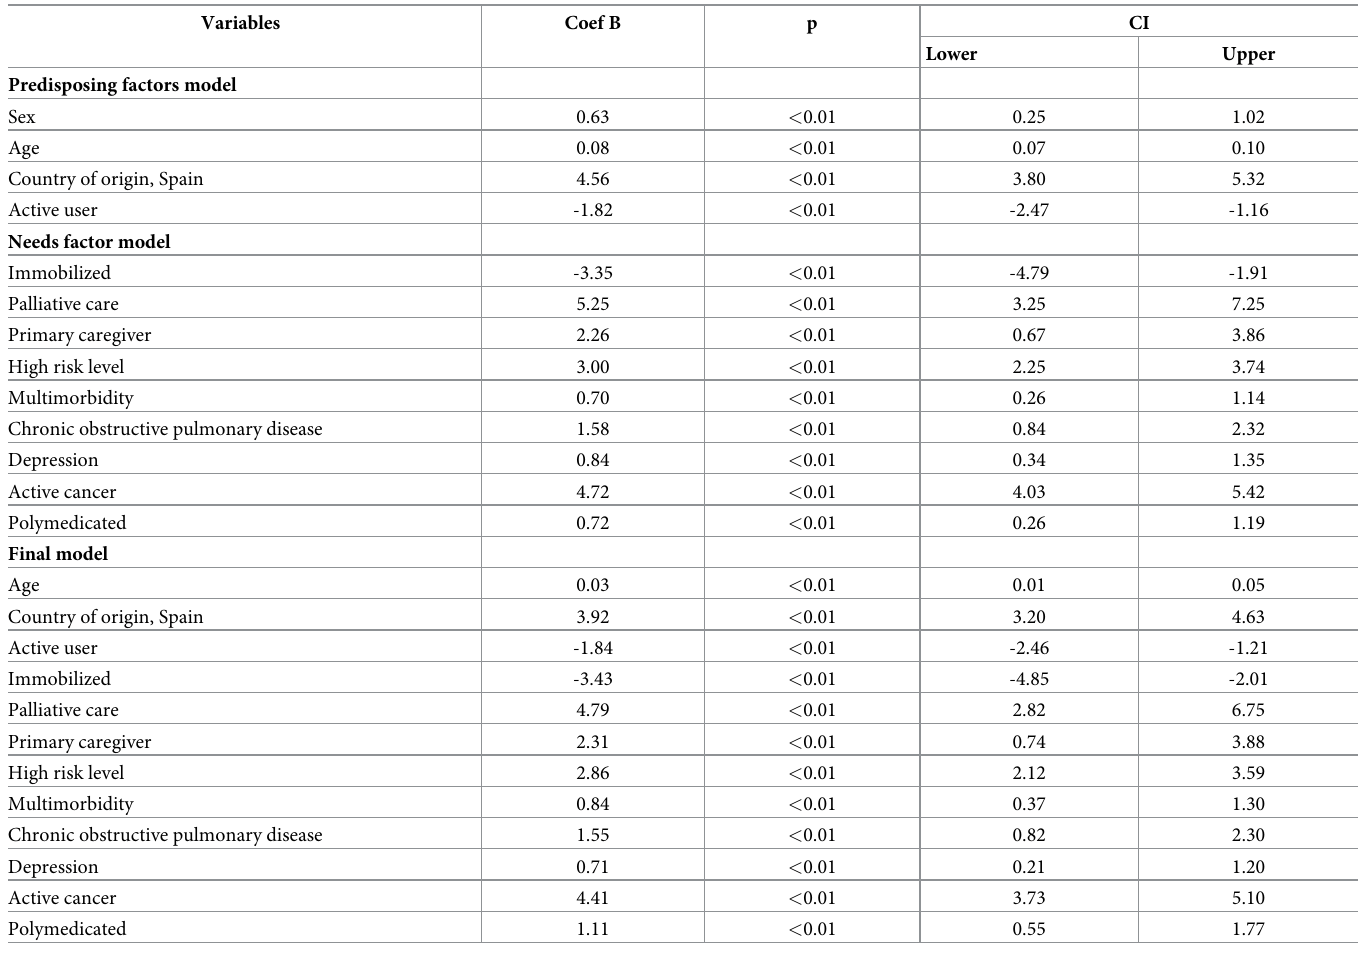
Table 5. Multivariate analysis of the variables correlated with the number of total contacts with HC.